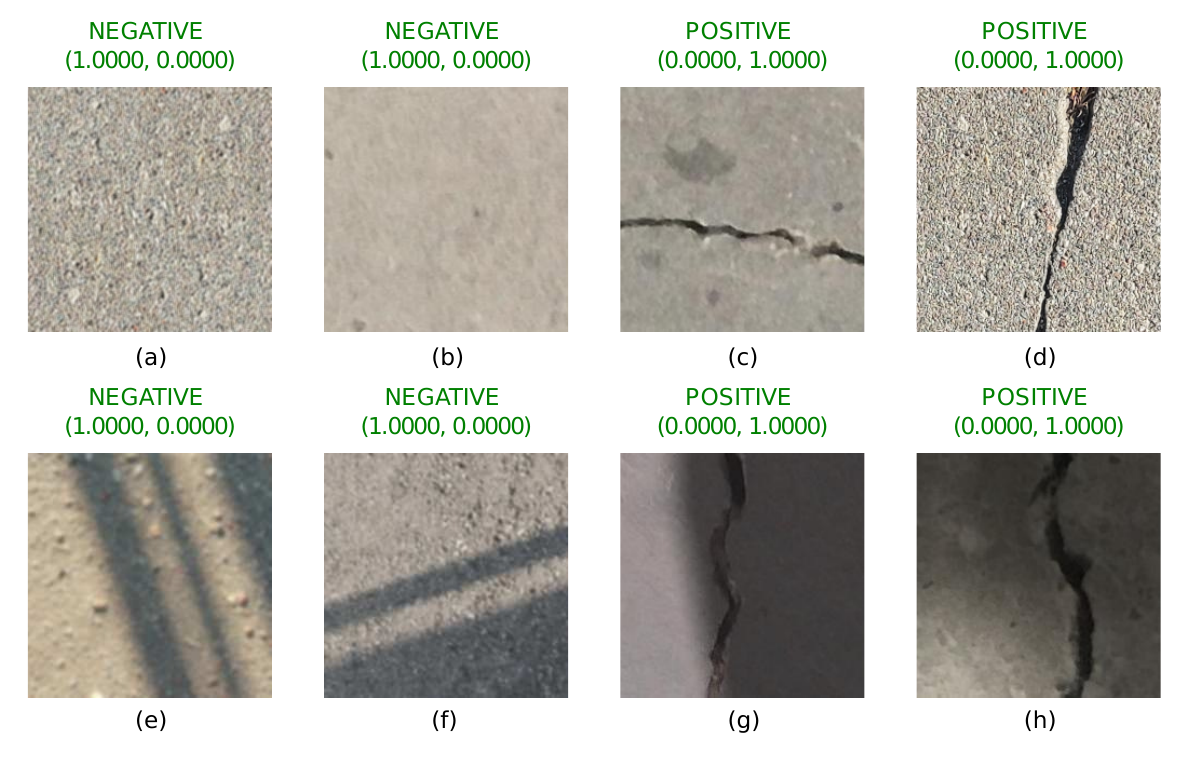
Figure 7. The model trained on the augmented Mendeley “Concrete Crack Images for Classification” produces correct results in the presence of shadows. Images without cracks and shadows in parts ( a , b ) and with cracks and without shadows in parts ( c , d ) are classified correctly. Images without cracks but with shadows in parts ( e , f ) and images with cracks and shadows in parts ( g , h ) are now also classified correctly. Figure shows the improvement achieved with new algorithm in classification of cracks compared to Figure 3.